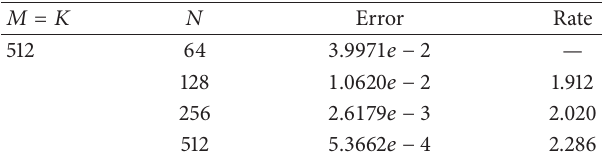
Table 3: Numerical results for Test 2.